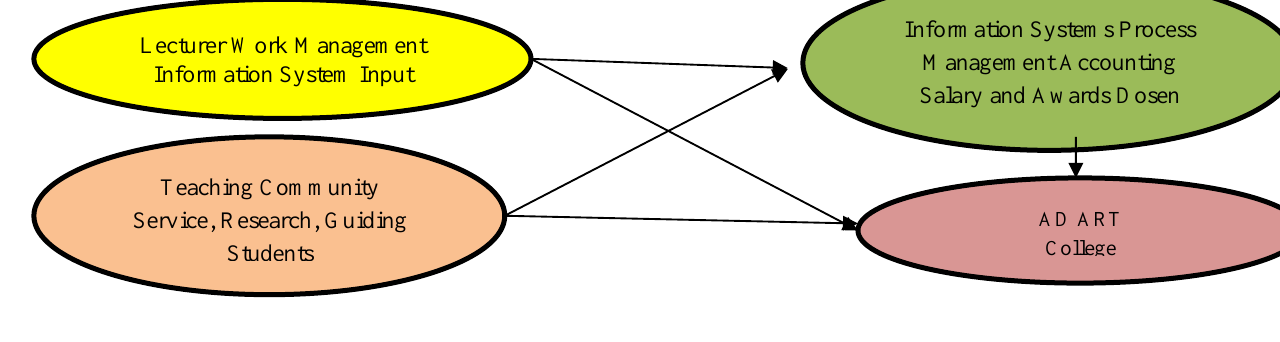
Figure 1: Research